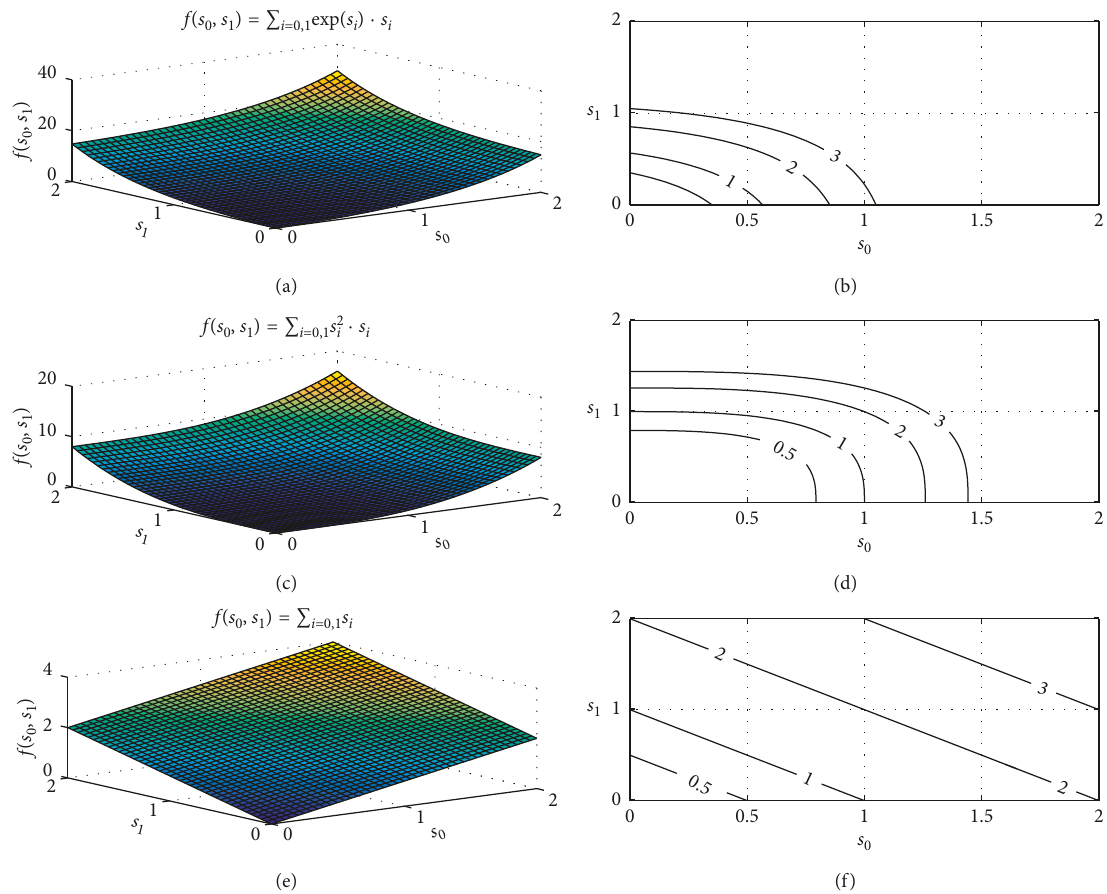
Figure 5: Performance curves of three weighted fitness